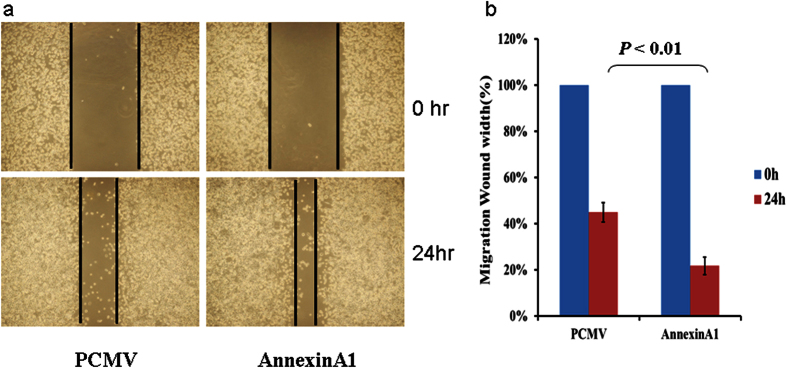
Annexin A1 overexpression in AGS cells promote migration.AGS cells were transfected with either control (PCMV) or an expression plasmid carrying Annexin A1 cDNA for 6 hours and migration was assessed by wound healing assay using 6-well plates. (a) Representative images of wound healing assay. (b) Bar graph showing migration as percentage of AGS cell migration at 0 hour.